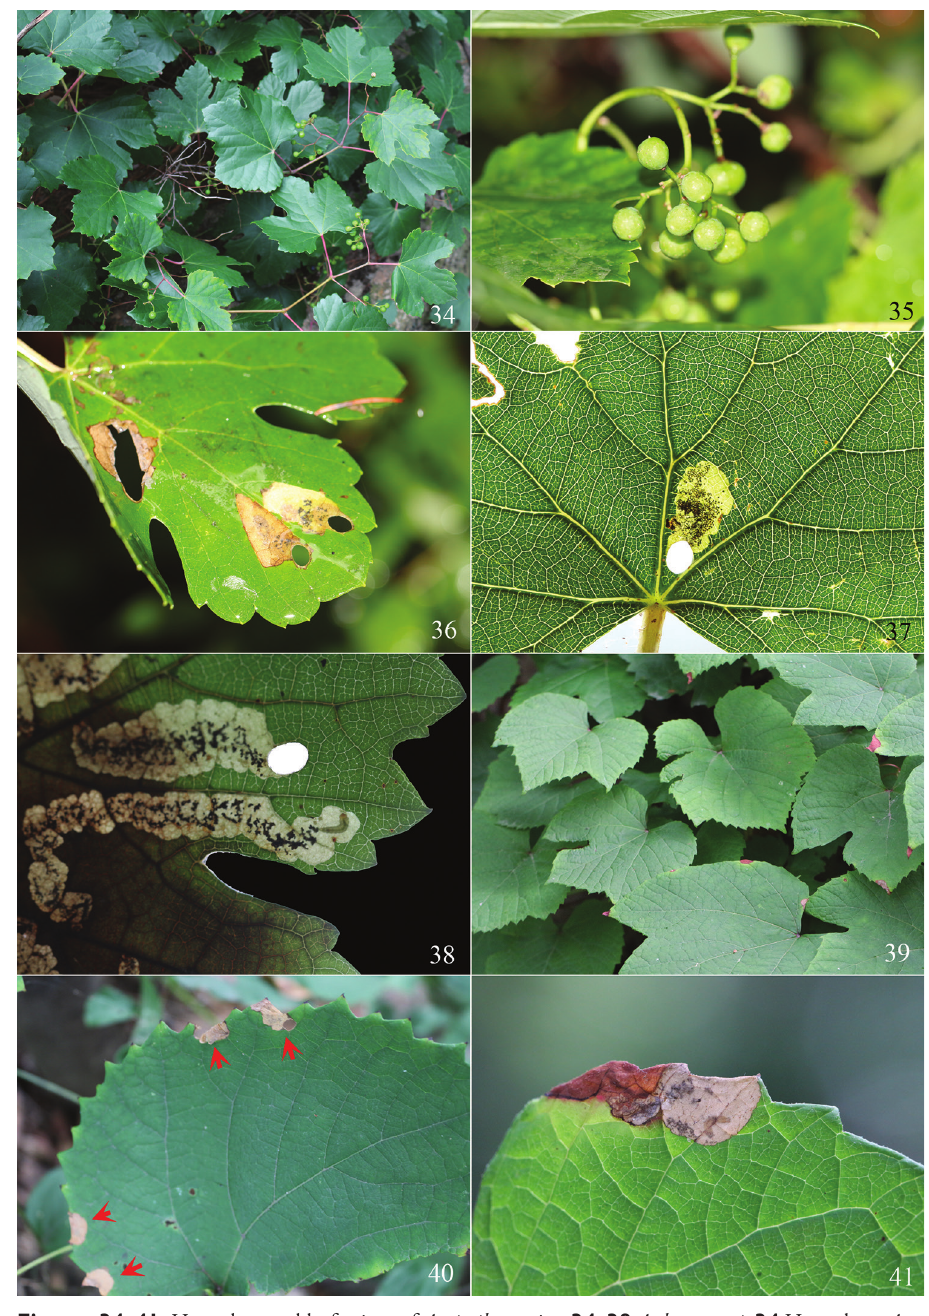
Figures 34–41. Host plant and leaf-mines of Antispila species. 34–38 A. kunyuensis 34 Host plant, Am- pelopsis humulifolia 35 unripe fruits of A. humulifolia 36–38 leaf-mines 39–41 A. uenoi 39 Host plant, Vitis amurensis 40 leaf-mines along leaf margin, indicated by red arrows 41 leaf-mine with a dead